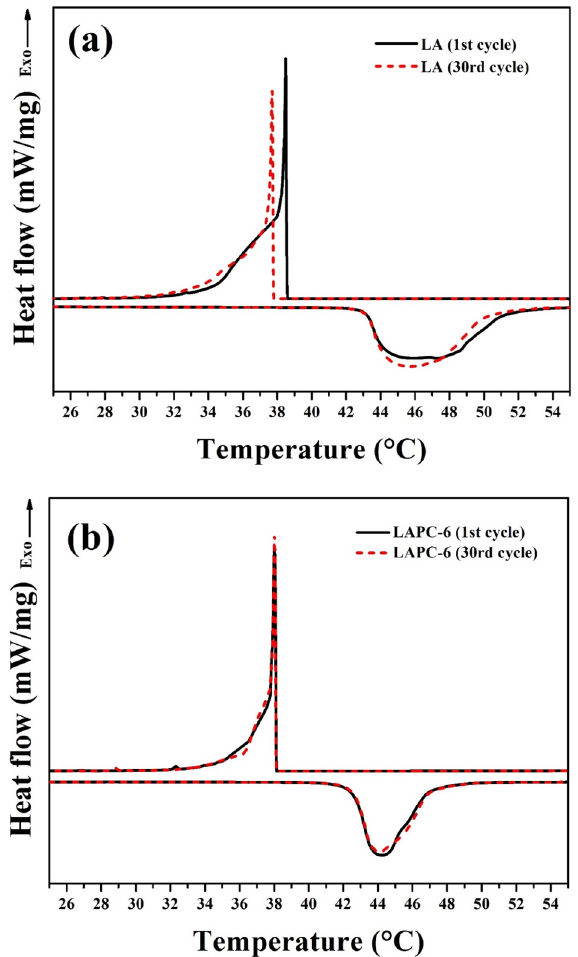
Figure 13. Thermal cycles of ( a ) LA and ( b ) LAPC-6 at 1st and 30th cycles of heating and